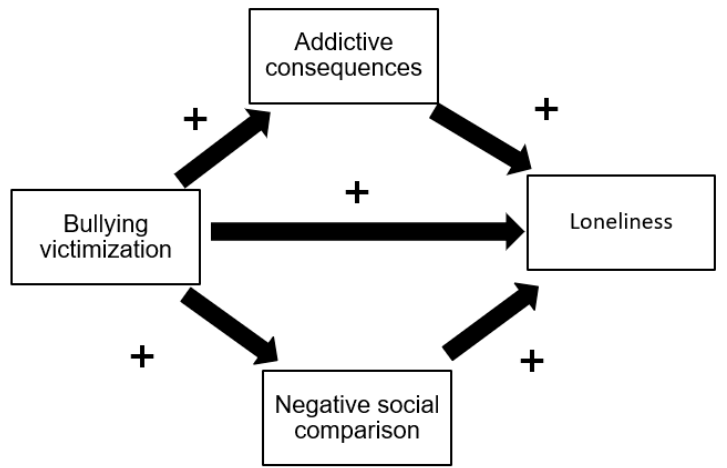
Figure 1. A conceptual framework illustrating the pathways from exposure (bullying victimiza- tion) to outcome (loneliness [10]) through mediators (addictive consequences [16,42,44] and negative social comparison [36,37]).